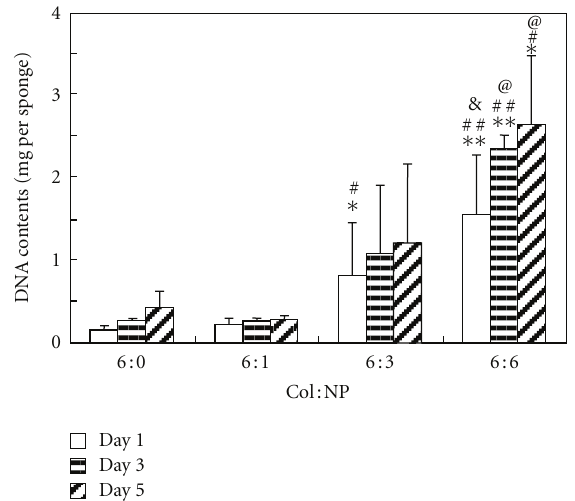
Figure 7: DNA contents of L929 fibroblast cells in the hybrid sca ff olds. n = 4, ∗ P < 0 . 05, ∗∗ P < 0 . 01 (compared to sponges with Col:NP = 6:0 (w:w) at day1, day3, or day5, resp.), # P < 0 . 05, ## P < 0 . 01 (compared to sponges with Col:NP = 6: 1 (w:w) at day1, day3, or day5, resp.), & P < 0 . 06, @ P < 0 . 05 (compared to sponges with Col:NP = 6:3 (w:w) at day1, day3, or day5,